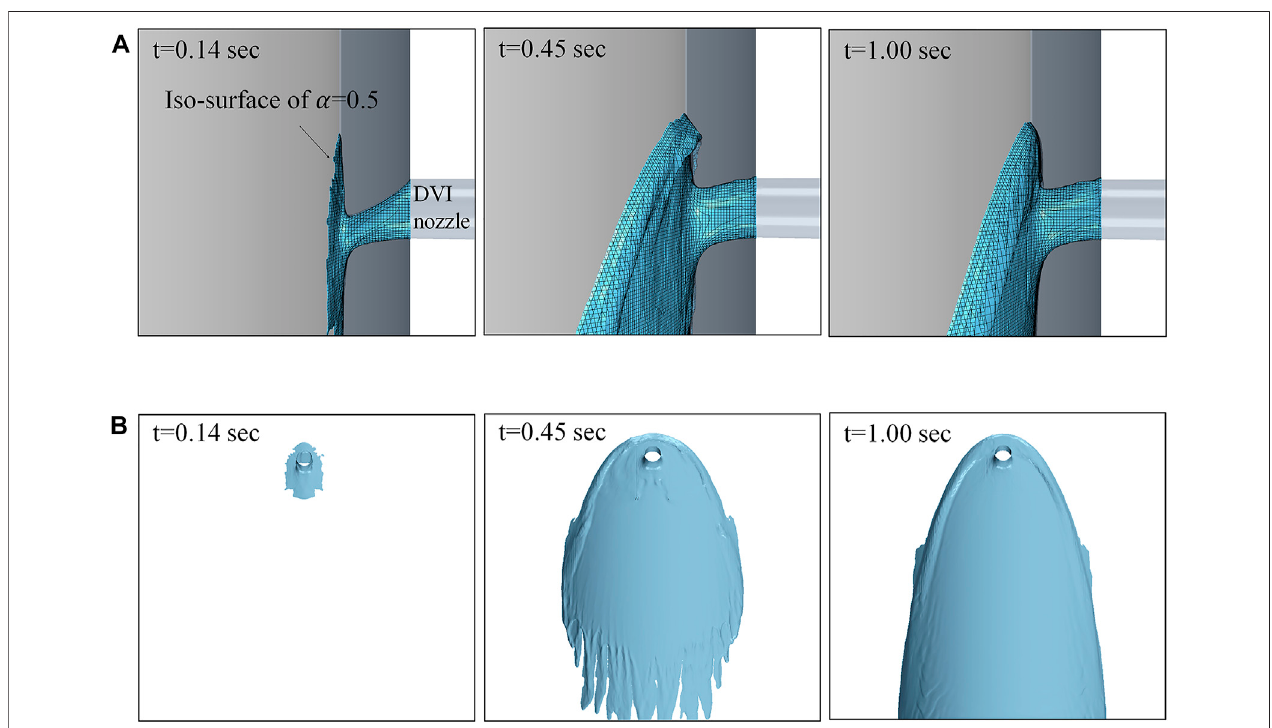
FIGURE 3 | Transient simulation under no-air fl ow condition (W089A00). (A) Water impingement (side view). (B) Liquid fi lm fl ow (front view).